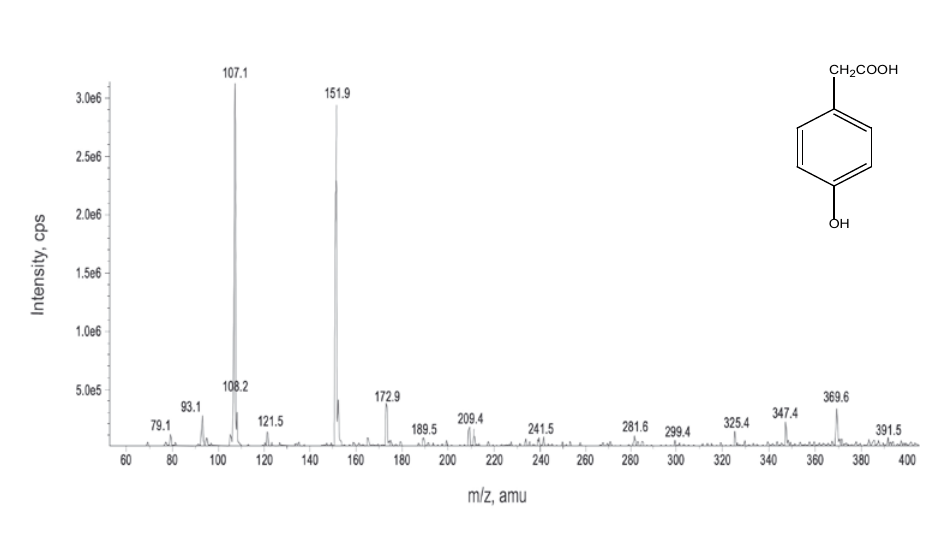
Figure 2. Portion of the LC-MS spectra showing a molecular ion peak (m/z) at 152 amu, confirming the presence of 4-hydroxyphenylacetic